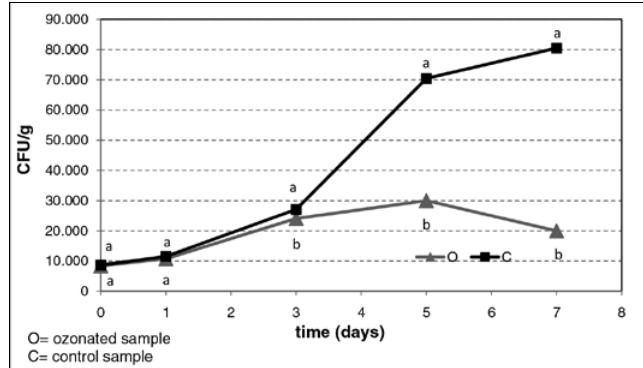
Fig. 1 - Evolution of total mesophilic bacteria during storage at 4°C. For each storage time, data followed by different letters are signifi- cantly different (t- Student test at p<0.05).